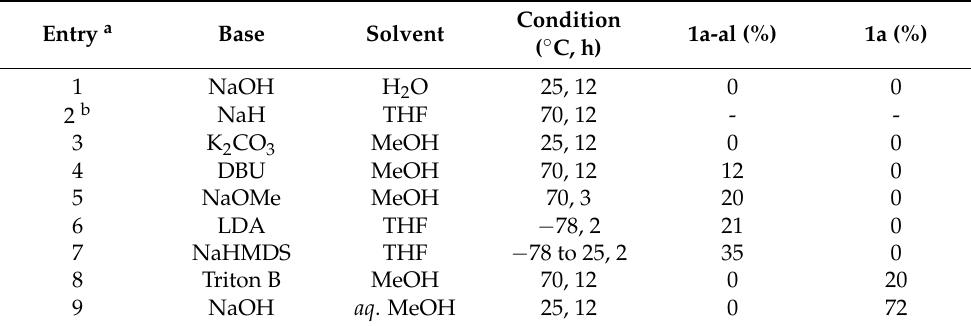
Table 1. Optimization study for aldol condensation between C 10 dial 1 and acetophenone—Product yields of 1a-al (mono-coupling) and 1a